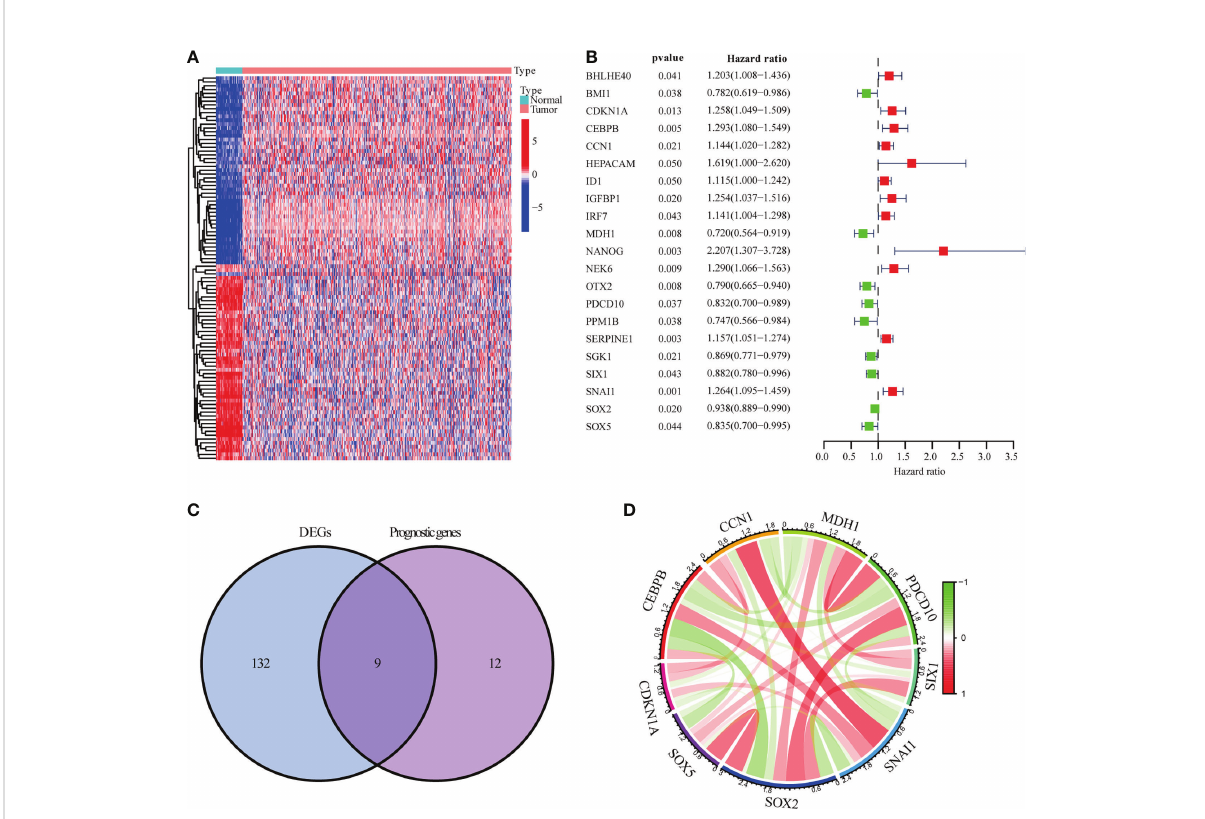
FIGURE 1 Genes linked to prognostic senescence. (A) The TCGA-LUSC heatmap of 141 DEGs. (B) The study of 21 hub genes using Univariate Cox regression. (C) A Venn diagram depicting DEGs linked to OS. (D) Correlation network of genes linked to cellular